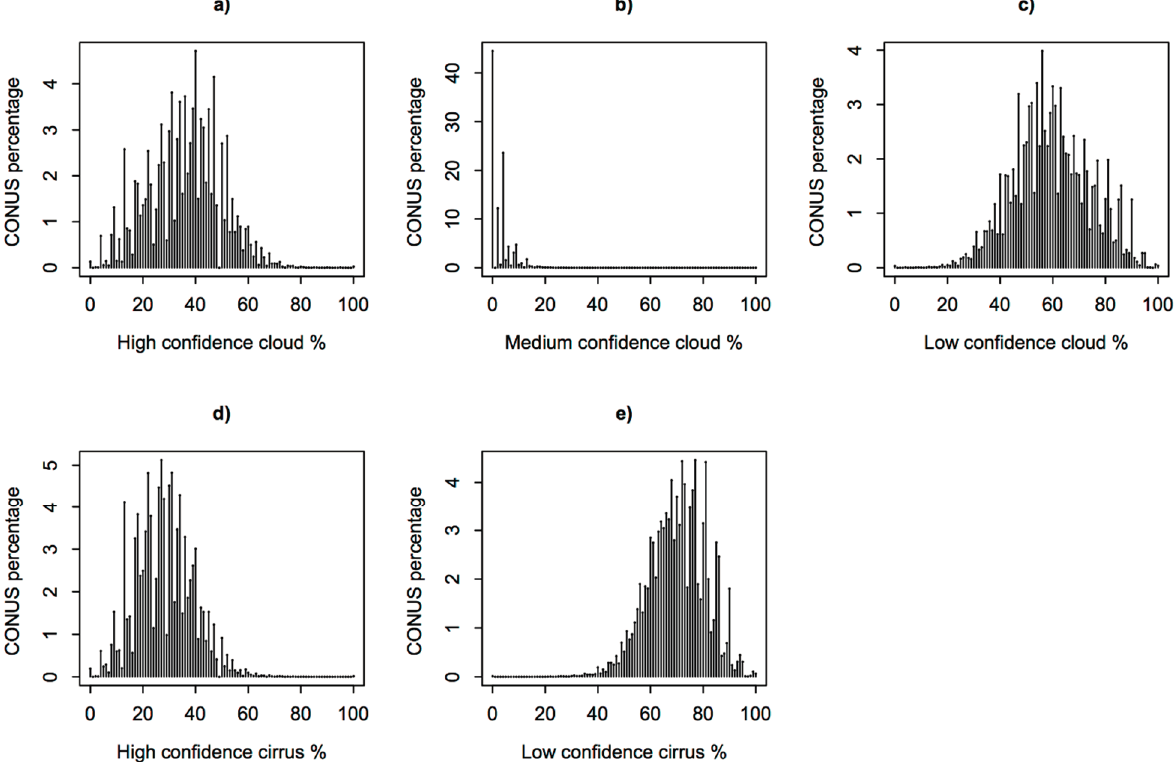
Figure 5. ( a – c ) Histograms of the conterminous US (CONUS) percentage values of the different cloud and ( d , e ) cirrus annual percentages derived over 53 weeks of Landsat 8 observations at each 30 m conterminous US Albers projection pixel location. Percentages were derived considering 11,088,916,742 30 m CONUS pixel values. Thus, (a,d) reflect histograms of the data illustrated in Figures 2 and 3, respectively, but derived at 30 m